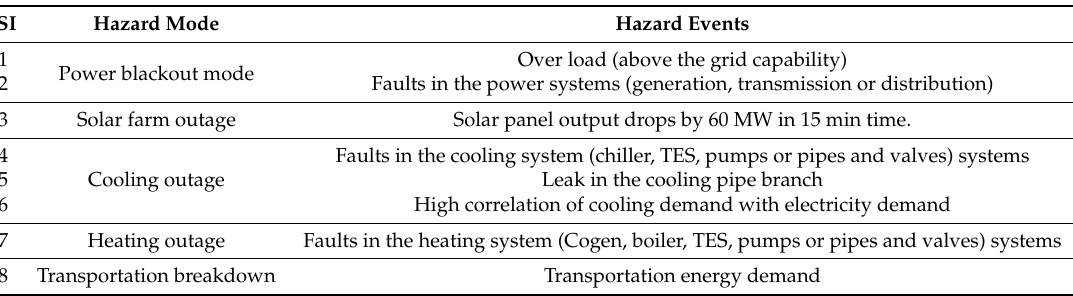
Figure 3. MEG hazards chart. Table 3. Hazard events in catastrophic range.